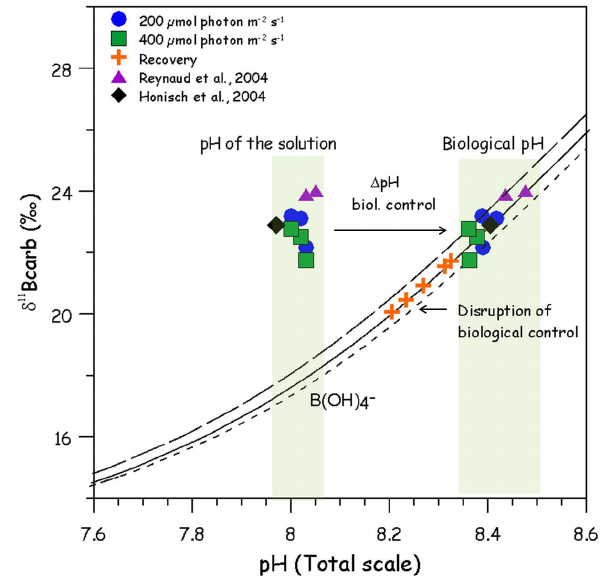
Fig. 4. Mean δ 11 B (‰) measured at the end of step 2 on corals grown under 200 (blue dots) and 400 (green squares) pho- tonm − 2 s − 1 , plotted vs. growth medium pH and reconstructed pH at the site of calcification using the fractionation factor deter- mined by Klochko et al. (2006) ( α = 1 . 0272 ± 0 . 0006; borate curve lines for δ 11 B seawater = 39 . 61‰, B T =416µM (DOE, 1994) and T = 22 ◦ C (small dashed line), T = 25 ◦ C (solid line), T = 28 ◦ C (large dashed line)). Black diamond and purple triangles represent values measured by H¨onisch et al. (2004) and Reynaud et al. (2004), respectively. Orange crosses represent mean δ 11 B (‰) measured at the end of step 3 (recovery experiment) plotted vs. reconstructed site of calcification pH using the fractionation factor determined by Klochko et al. (2006) α = 1 . 0272 ± 0 .